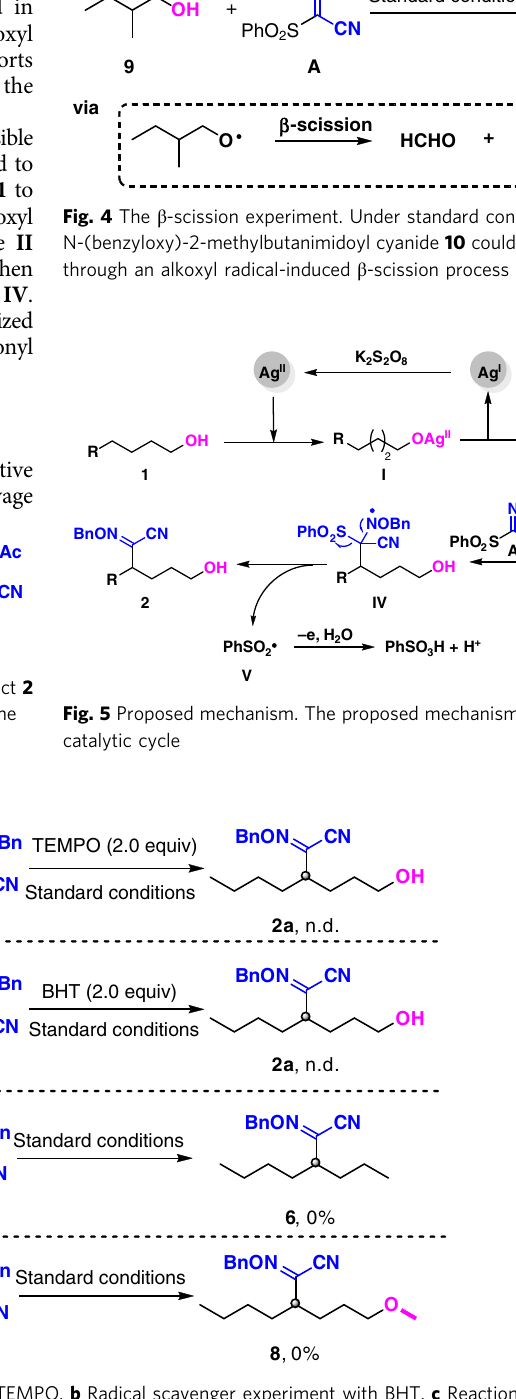
Fig. 3 The mechanistic studies. a Radical scavenger experiment with TEMPO. b Radical scavenger experiment with BHT. c Reaction of n -octane under standard conditions. d Reaction of protected alcohol under standard conditions